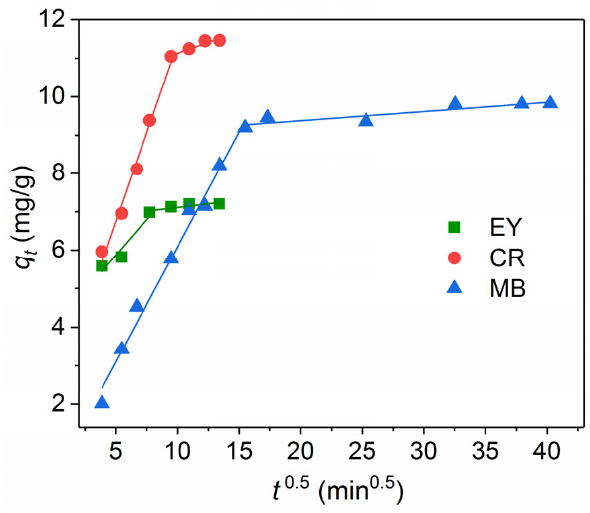
Figure 10. Intraparticle diffusion kinetic model of the dye adsorption on the amino-functionalized Fe 3 O 4 @SiO 2 core-shell magnetic NPs at 25 °C.